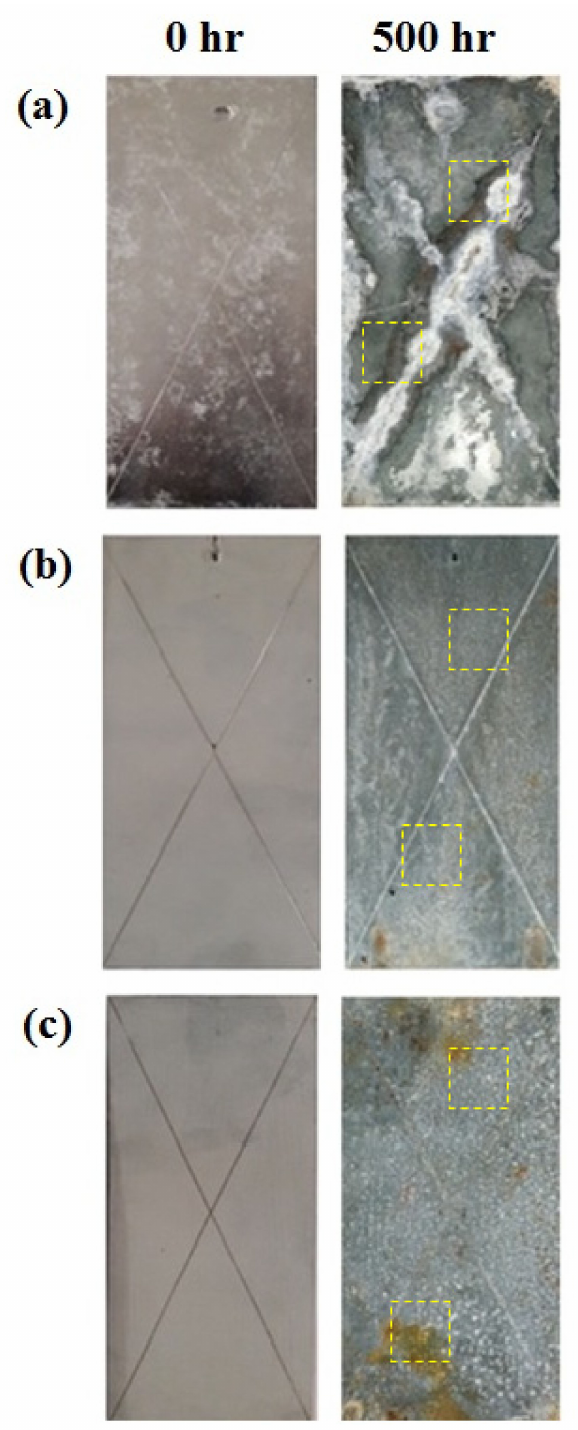
Figure 7. Surface features of coated panels after 500 h of exposure to salt spray: ( a ) GS, ( b ) BS, ( c )